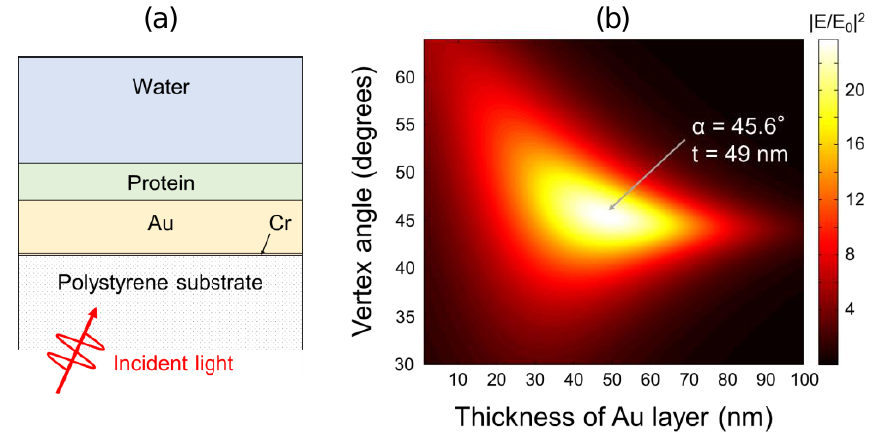
Figure 3. ( a ) Schematic of the cross section of the V-trench sensor chip surface used in the electric field simulation of a multi-layer model based on the transfer matrix method; ( b ) Calculated electric field enhancement factor (|E/E 0 | 2 ) against the thickness of the gold layer ( t ) and the vertex angle of the V-trench ( α ). The excitation wavelength is 670 nm, and |E/E 0 | 2 at the boundary between the protein and water layers is shown. The arrow indicates the point of maximum |E/E 0 | 2 .